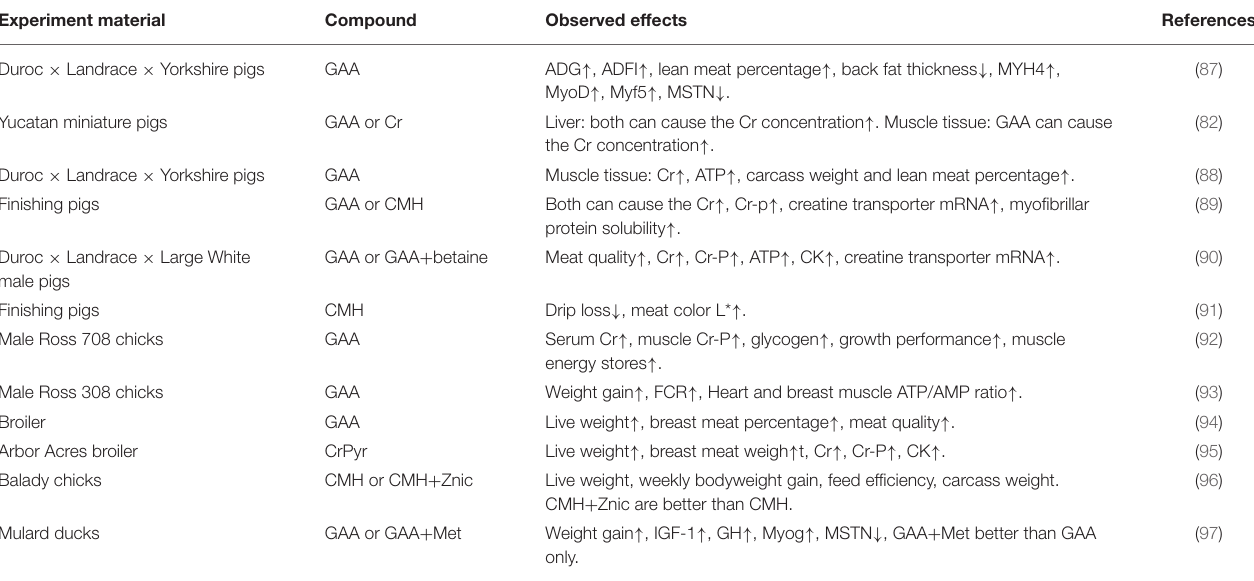
TABLE 1 | The results of using GAA or Cr in livestock